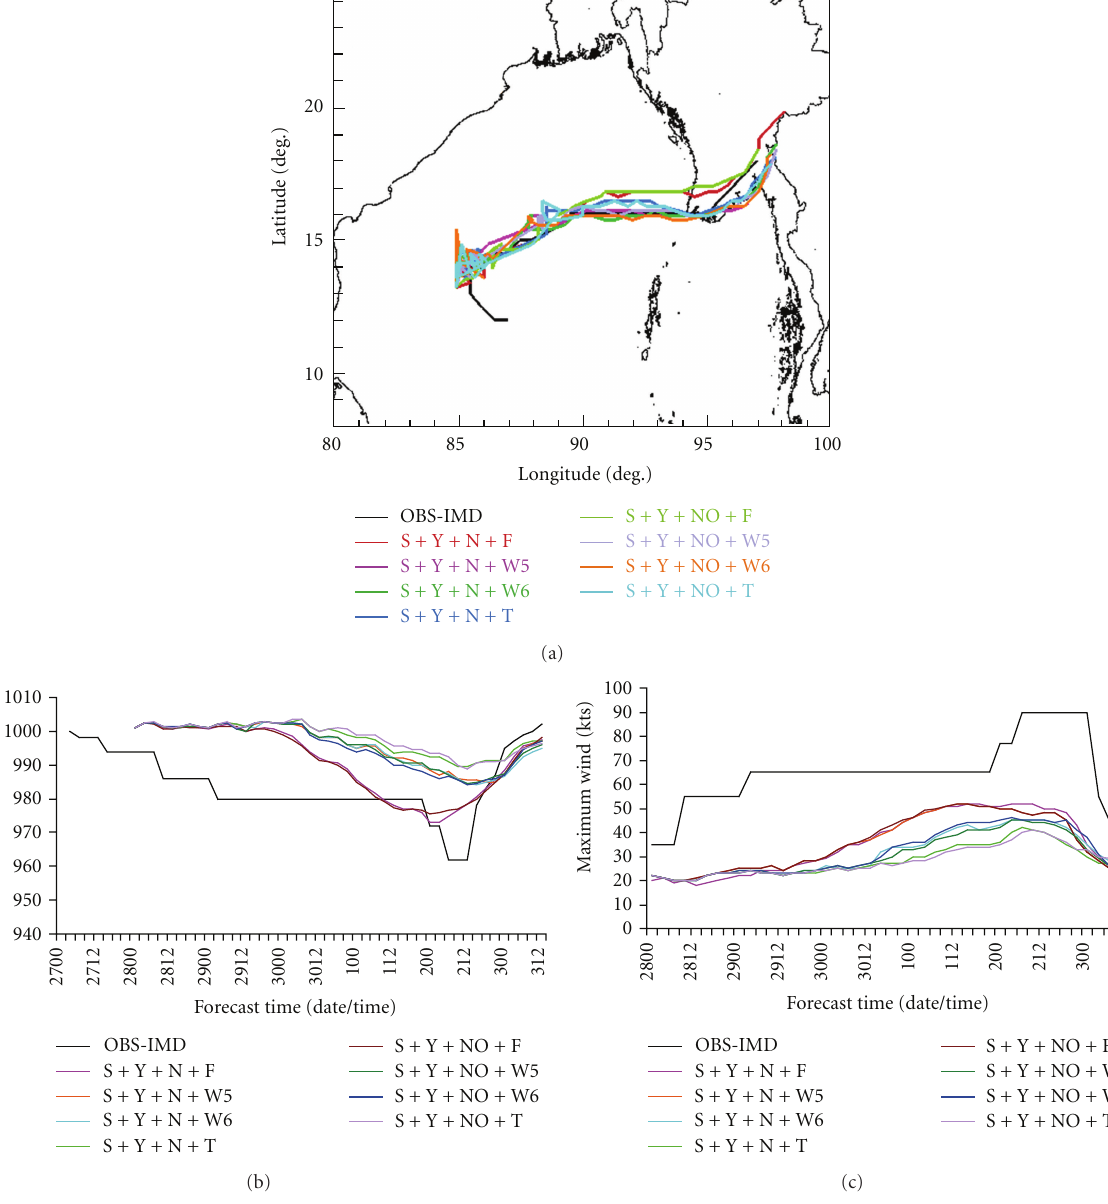
Figure 5: (a) Track, (b) MSLP (hPa), and (c) maximum wind (kts) of the cyclone NARGIS with best cumulus convections, best PBL, 2 best land surface schemes, and 4 di ff erent microphysics